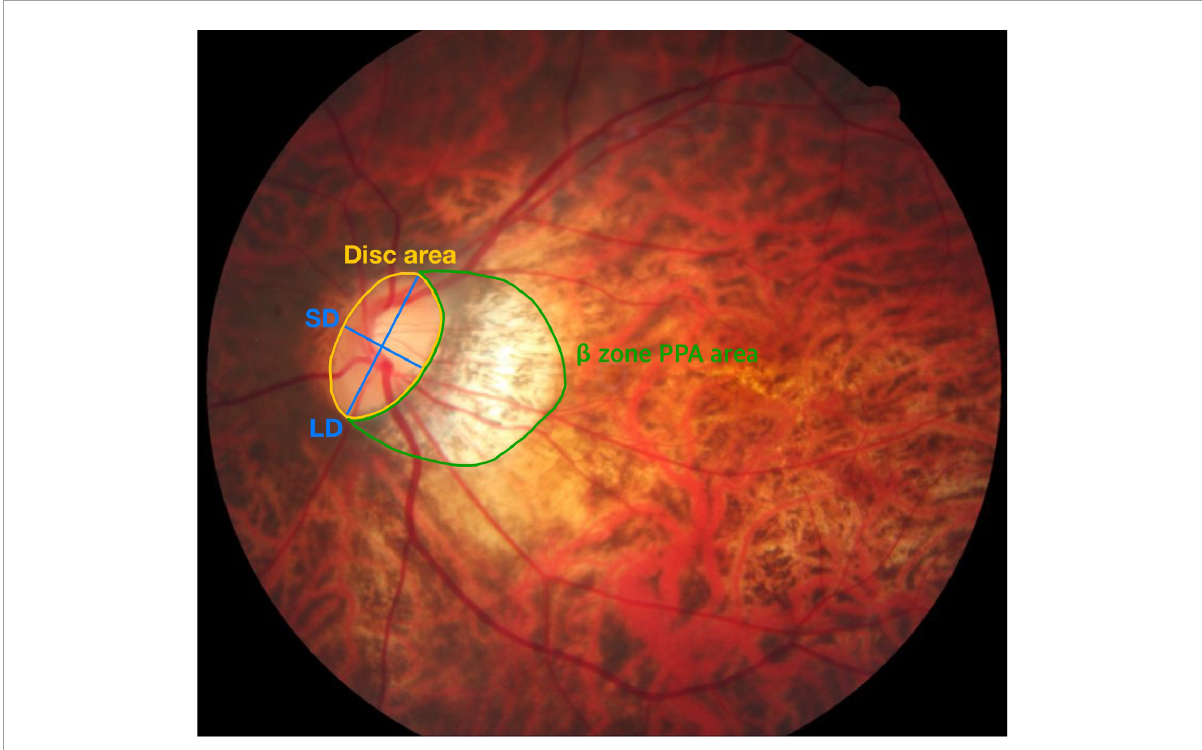
FIGURE1 Measurement of the β -PPA-to-disc area ratio (PDR) and tilt ratio. The optic disc area (demarcated by the yellow line) and β -zone peripapillary area ( β -PPA, demarcated by the green line) were automatically calculated in pixel area using the Image J software. The β -PPA-to-disc area ratio (PDR) was used to minimize the effects of photographic magnification error and represent the β -PPA. Blue lines indicate the shortest diameter (SD) and the longest diameter (LD) of the optic disc. The tilt ratio was defined as the LD-to-SD